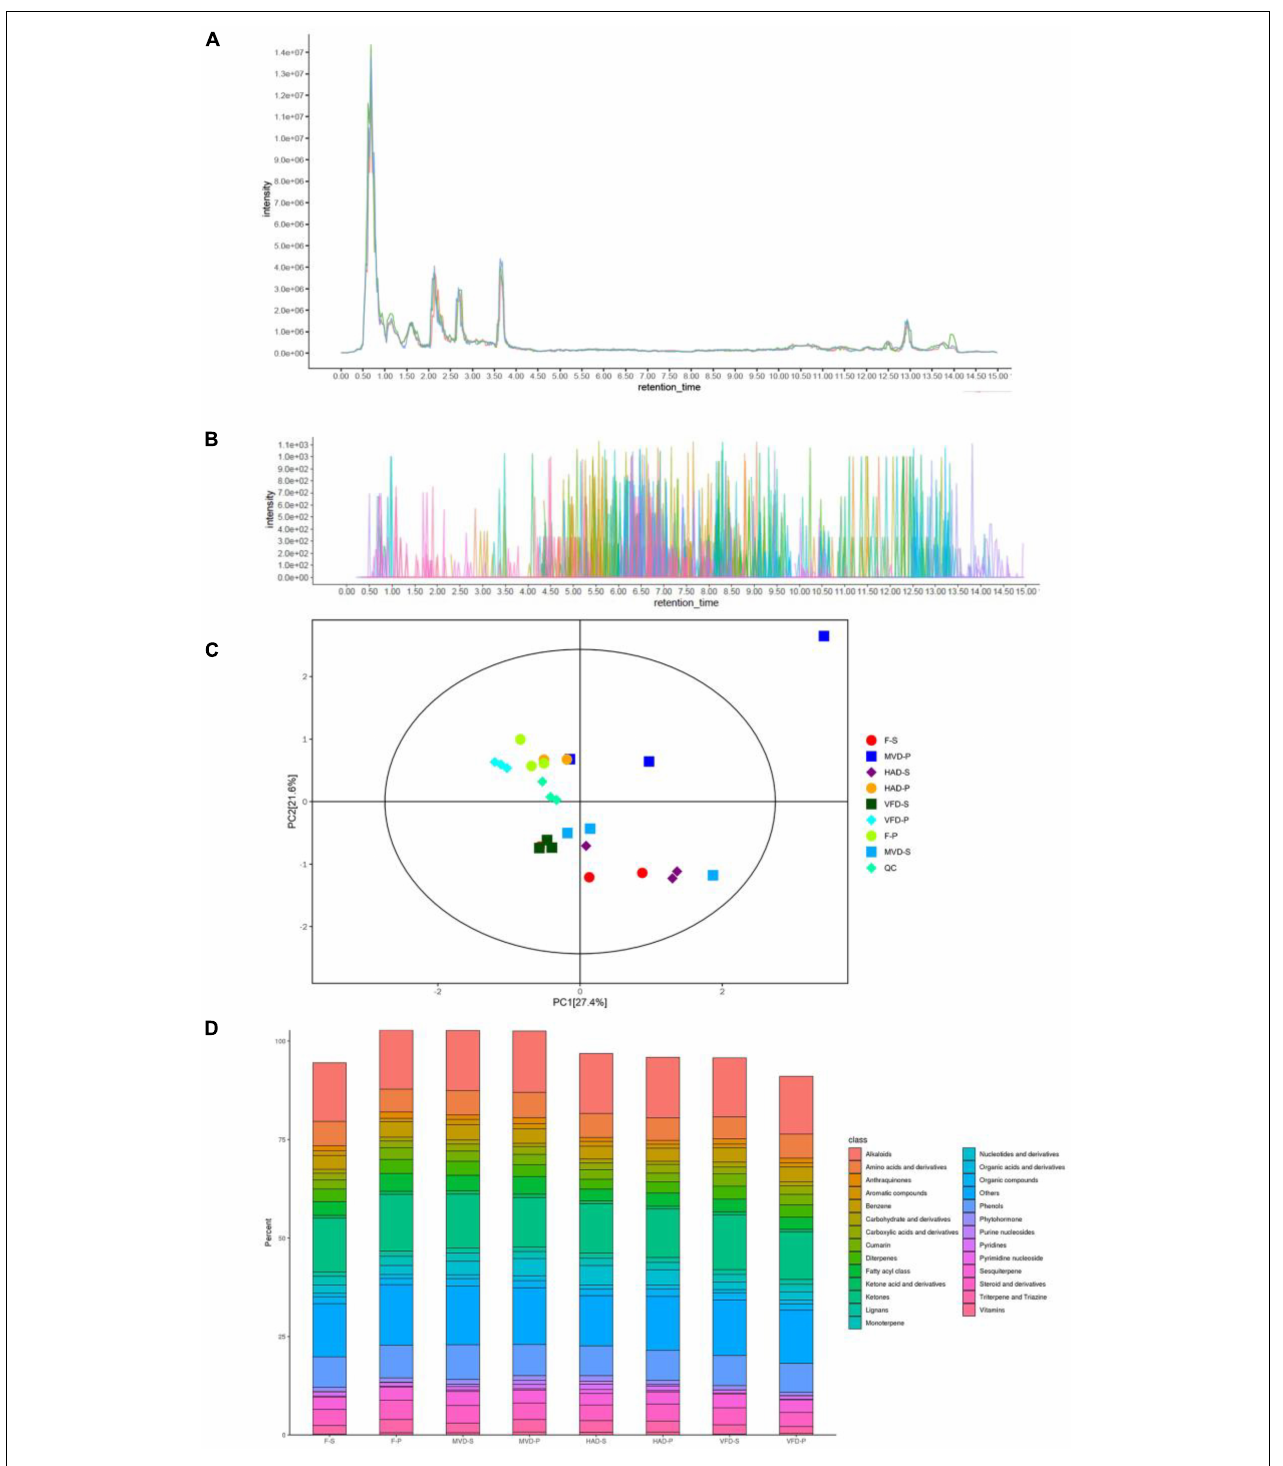
FIGURE 1 | (A) Total ion current of one quality control sample as revealed by mass spectrometry detection, and (B) a multi-peak detection plot of the sample metabolites in the multiple reaction monitoring mode. (C) PCA analysis of metabolites identified from the stipe and pileus of S. rugosoannulata mushrooms subjected to different drying methods. (D) Relative content of principal components. F-S, fresh stipe; F-P, fresh pileus; MVD-S, microwave vacuum drying of stipe; MVD-P, microwave vacuum drying of pileus; HAD-S, hot air drying of stipe; HAD-P, hot air drying of pileus; VFD-S, vacuum freeze drying of stipe; VFD-P, vacuum freeze drying of